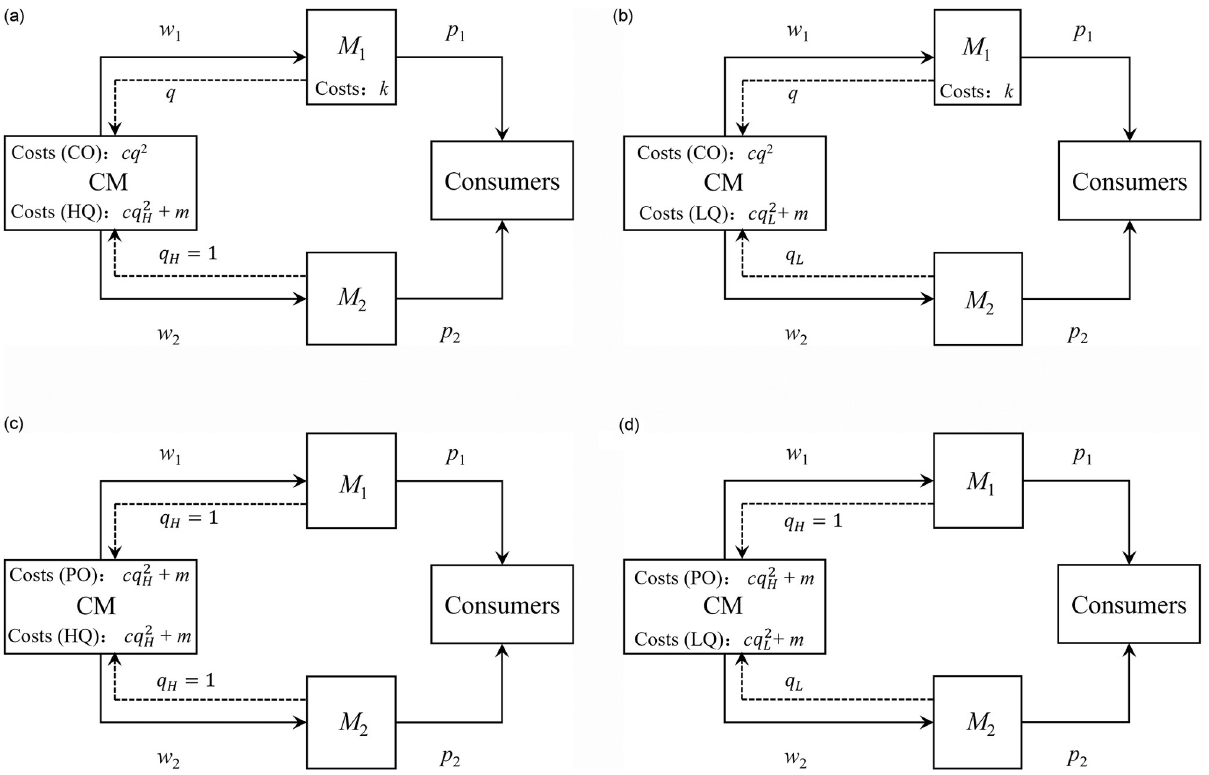
Fig 2. Four strategy combinations. (a) COHQ model, (b) COLQ model, (c) POHQ model, and (d) POLQ model.